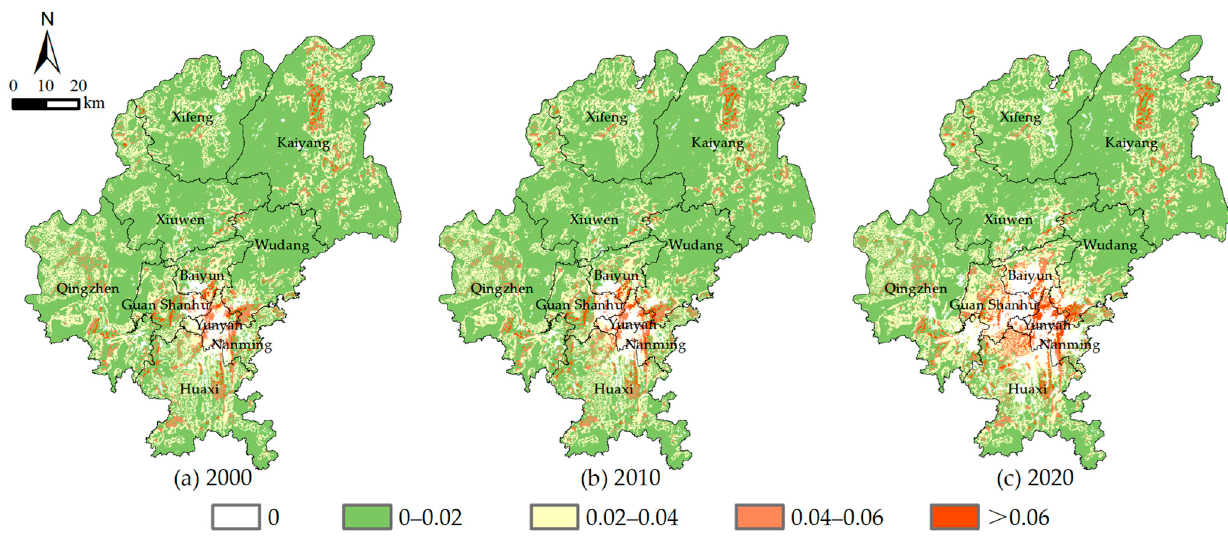
Figure 6. Spatio-temporal patterns of habitat degradation in Guiyang city from 2000 to Figure 6. Spatio ‐ temporal distribution of habitat degradation in Guiyang city from 2000 to 2020.